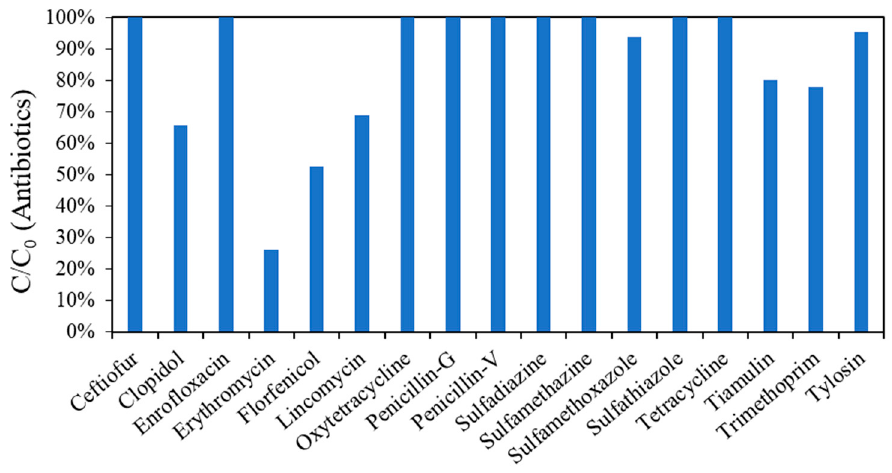
Figure 4. Photocatalytic degradation of antibiotics by UV/TiO 2 process after 30 min of UV illumina- tion. ([antibiotics] 0 = 50 μ g/L, [TiO 2 ] 0 = 0.1 g/L, pH = 5.8.) tion. ([antibiotics] 0 = 50 µ g/L, [TiO 2 ] 0 = 0.1 g/L, pH =